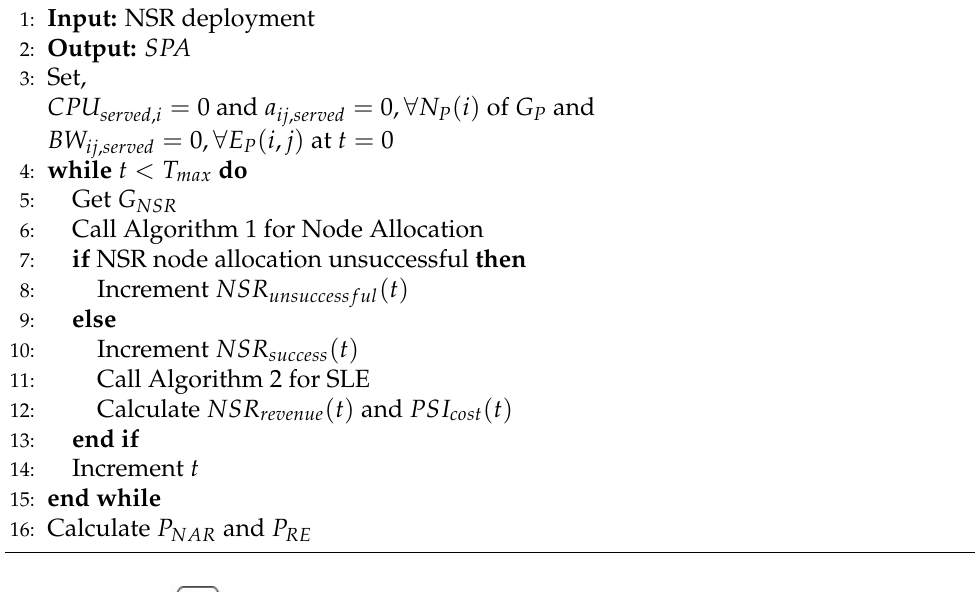
Algorithm 3 NSR deployment through hybrid PROMETHEE-II and SLE